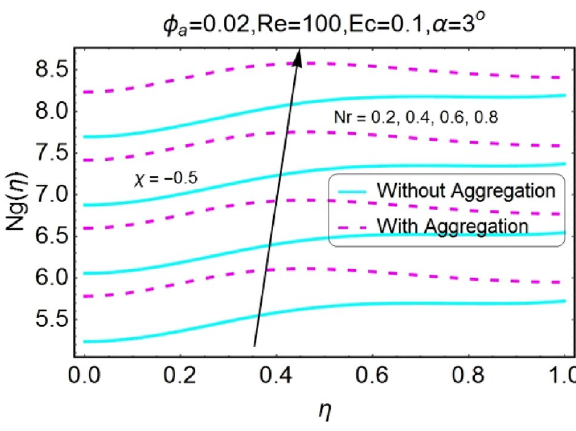
Figure 44. Nr varying Ng for shrinking walls (divergent channel).